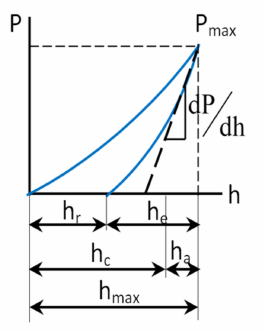
Figure 7. A loading and unloading displacement curves during nanoindentation.